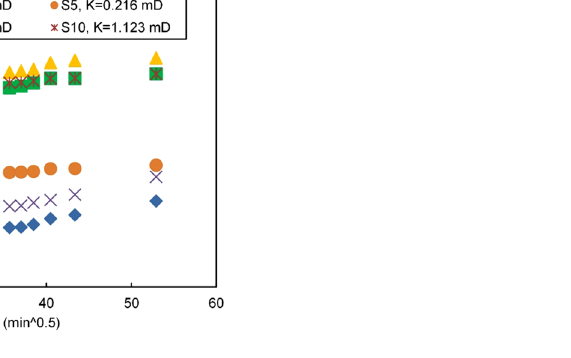
Figure 3. Water imbibition versus the square root of